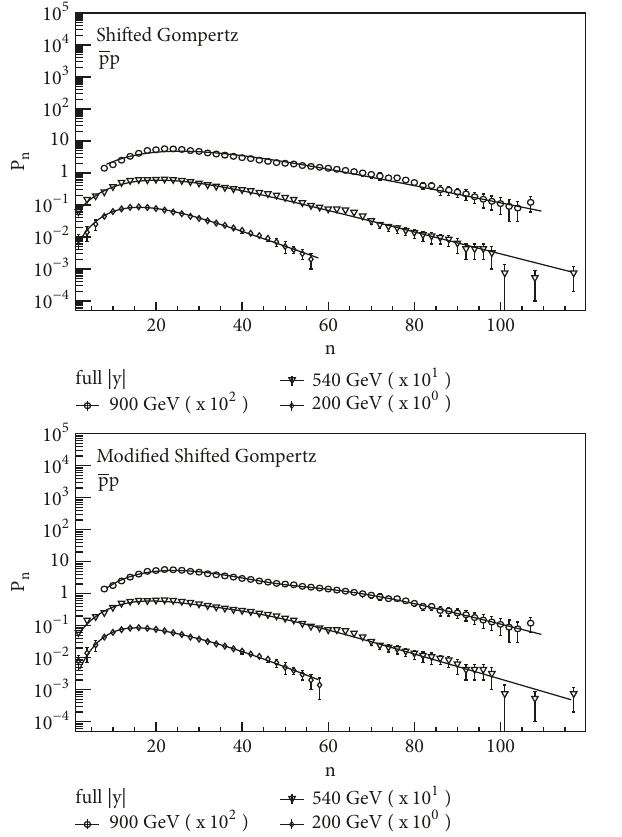
Figure 5: Charged multiplicity distributions in 𝑝𝑝 collisions in full phase space. Solid lines represent shifted Gompertz function (top) and modified shifted Gompertz distributions (bottom).